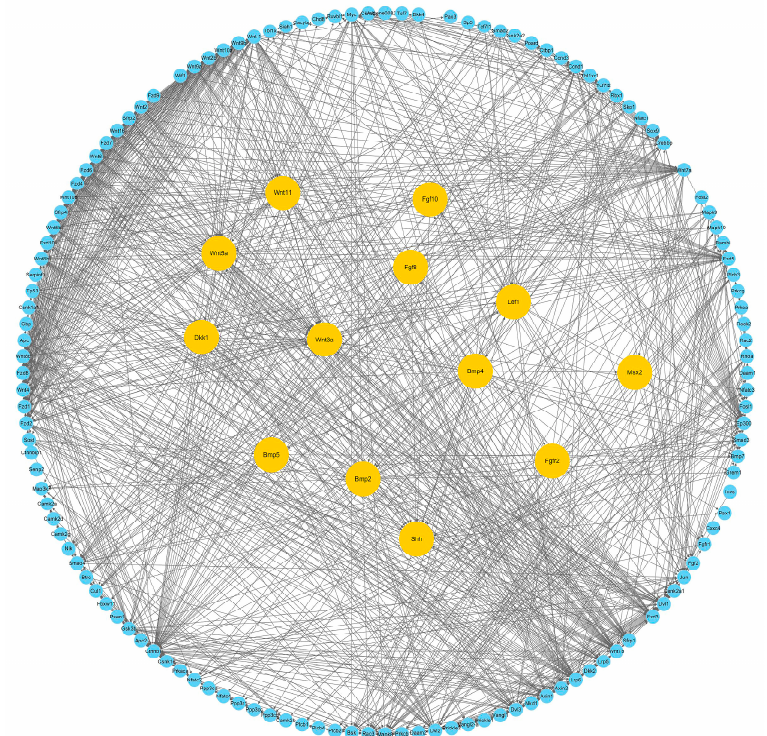
Figure 8. Interaction network of the Wnt signaling pathway. Genes Bmp4 , Bmp2 , Shh , Lef1 , Msx2 , Bmp5 , Fgf8 , Fgf10 , Wnt5a , Wnt11 , Wnt3a , Fgfr2 , and Fgfr1 are highlighted in yellow, and other genes are highlighted in blue. These relationships scored more than